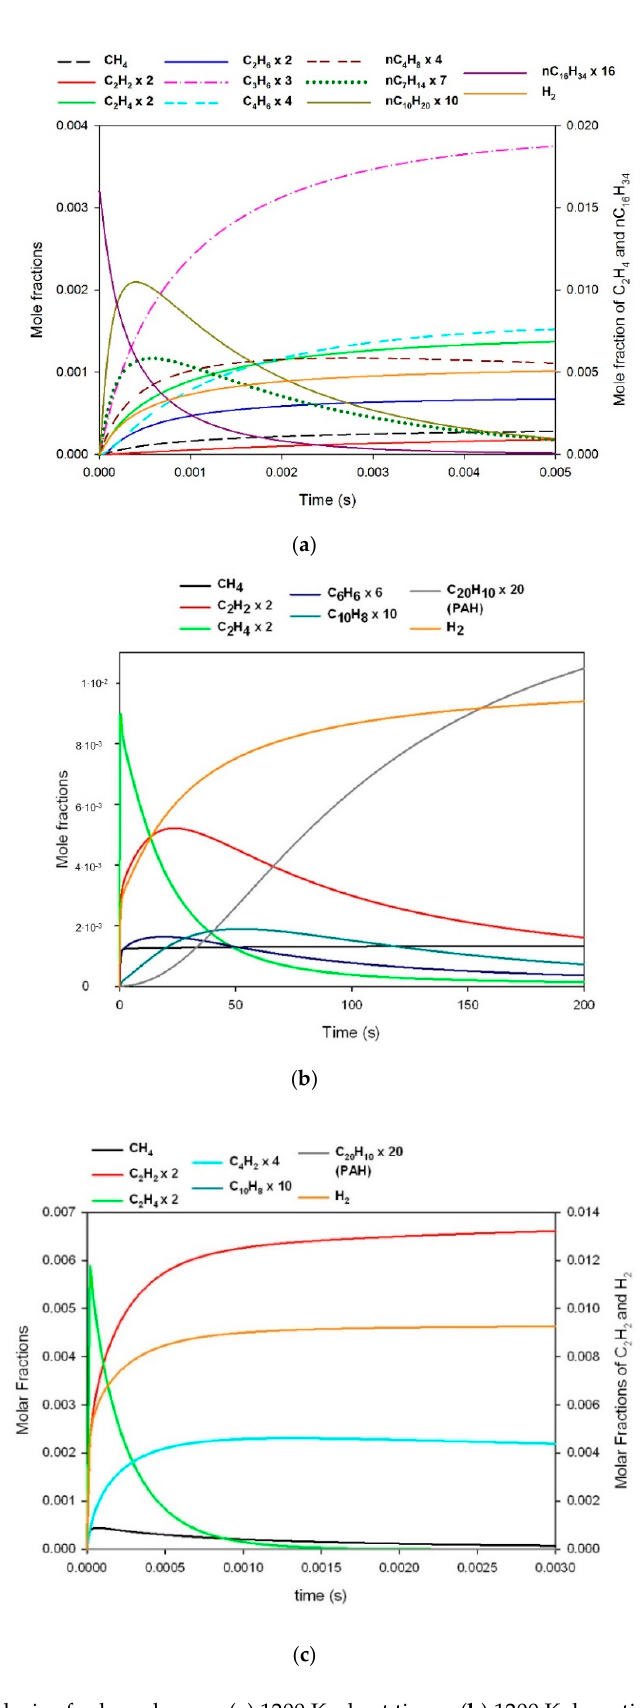
Figure 3. Pyrolysis of n-hexadecane. ( a ) 1200 K, short times; ( b ) 1200 K, long times; ( c ) 1900 K.